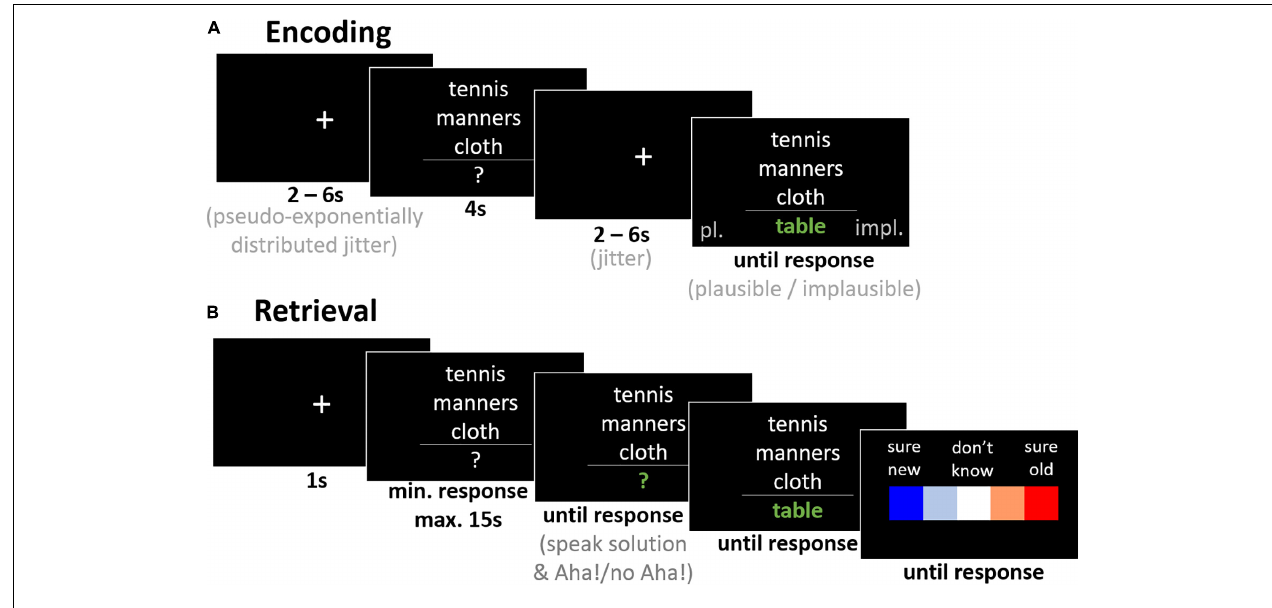
FIGURE 1 | Exemplary trials for the incidental encoding task (A) and the memory test (B)